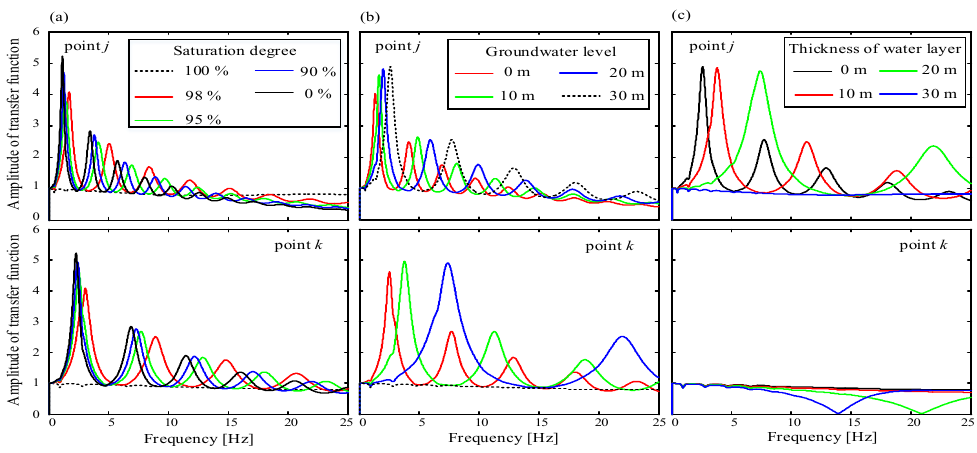
Figure 2. Amplitude of transfer function for varying: ( a ) SD; ( b ) GWL; ( c ) WLT. Figure 3 gives the mean lagged coherency loss and corresponding mean phase angle of the coherence function for the generated vertical in-plane motions, where the corresponding modulus of the spectral ratio between sites j and k are also given (here, spectral ratio is defined as the ratio between the transfer functions at sites j and k , and the peaks and troughs of the amplitude curve of the spectral ratio reflect the difference between the transfer function between sites j and k ). As can be seen, the troughs of each lagged coherency loss function are directly related to the peaks of the corresponding spectral ratios, and due to the topography effect, the amplitude of the coherency function exhibits additional loss, which is consistent with previous results [25]. As the SD increases, the lagged